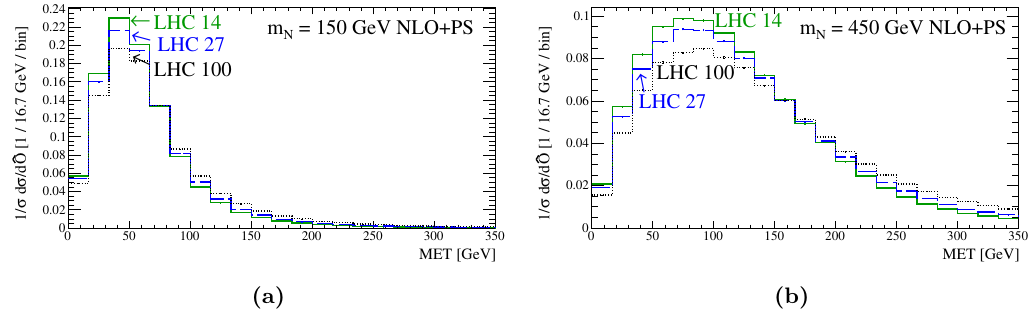
Figure 11. Normalized particle-level missing transverse momentum (MET) distributions for the pp N‘ 3 ‘(cid:23) process via the DY mechanism at NLO+PS, assuming representative neutrino ! ! mass (a) m N = 150 and (b) 450 GeV, at p s = 14 (solid), 27 (dash), and 100 (dot) TeV.